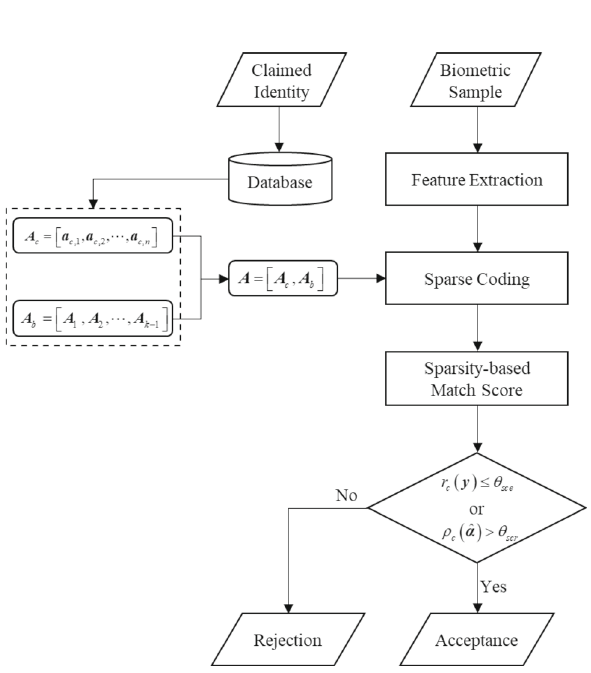
Fig. 2 The flowchart of SRC-based unimodal